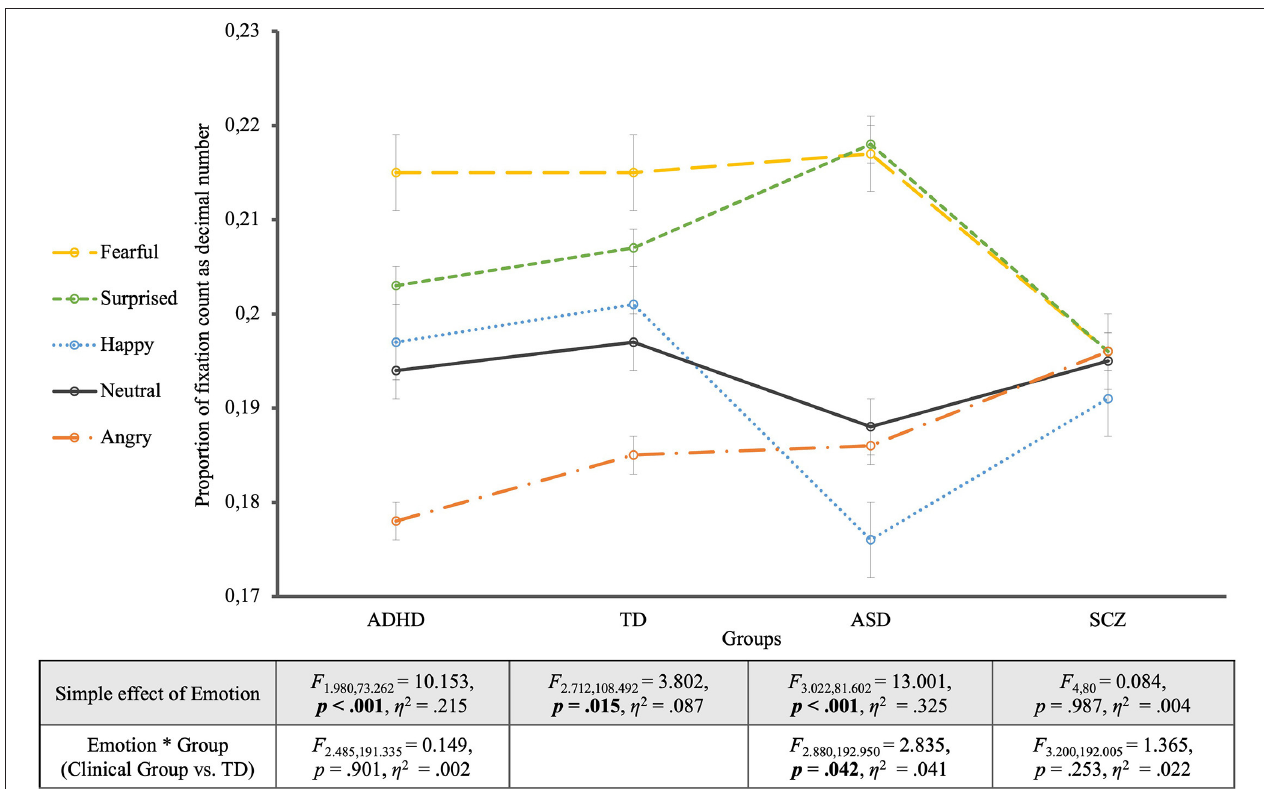
FIGURE 3 | Proportion of fixation count for the four groups. The groups are located on the horizontal axis with the different emotions as single lines. The table shows the statistics of the simple effects of EMOTION as well as the interaction effects EMOTION *